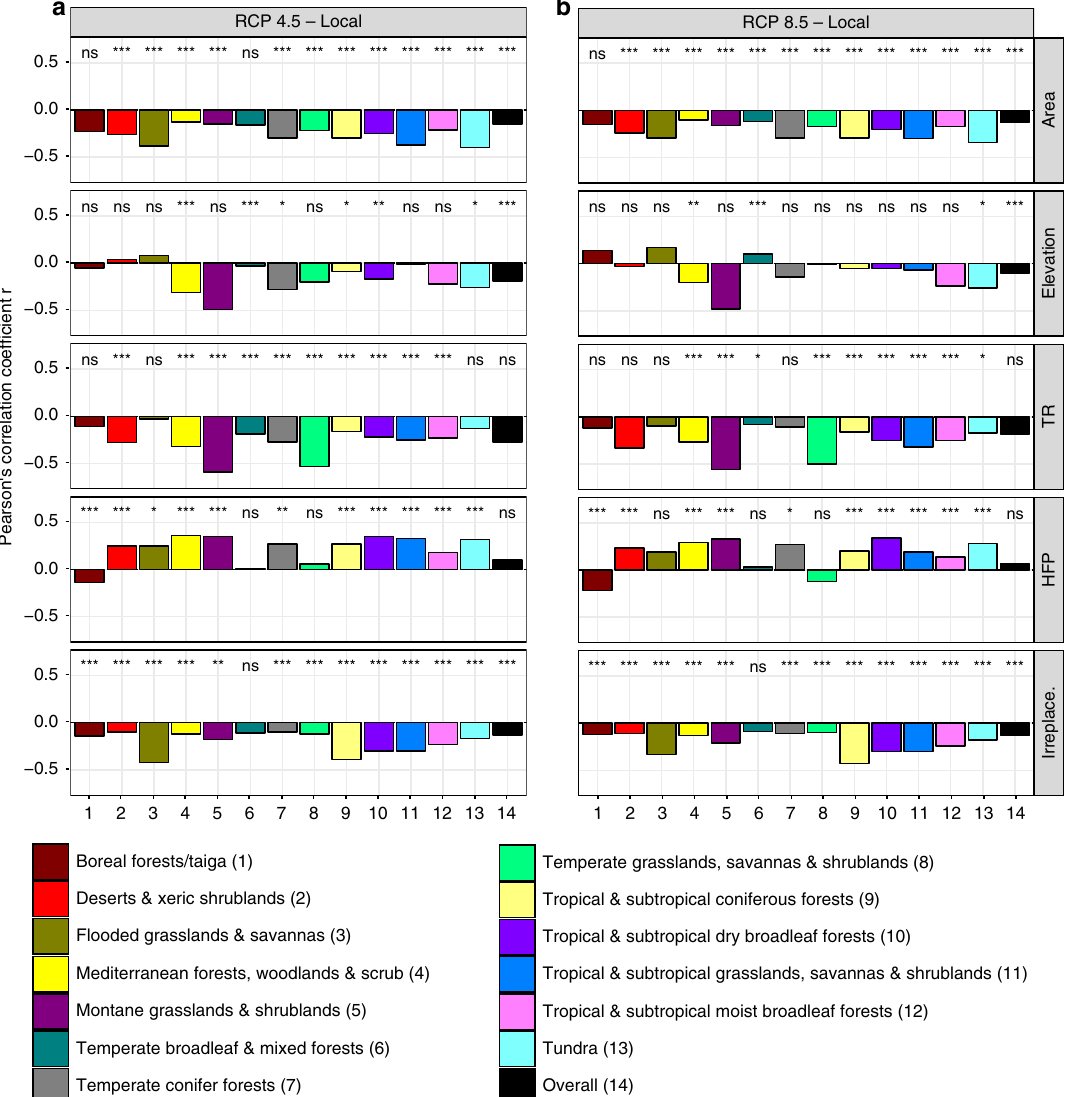
Fig. 6 Correlation between the mean values of the local-scale novel climate index and protected area characteristics, separated by biome and RCP scenario. a RCP 4.5 and b RCP 8.5. Bars show Pearson ’ s correlation coef fi cients r . Asterisks represent the signi fi cance level considering a modi fi ed t -test accounting for spatial autocorrelation 19 (* p ≤ 0.05, ** p ≤ 0.01, *** p ≤ 0.001), while “ ns ” implies non-signi fi cant ( p > 0.05) correlation. Note that “ TR ” stands for terrain ruggedness, “ HFP ” for human footprint index and “ Irreplace. ” for irreplaceability. Data on climate change metrics and other characteristics per PA are given as Supplementary Data 1. Source data are provided as a Source Data fi